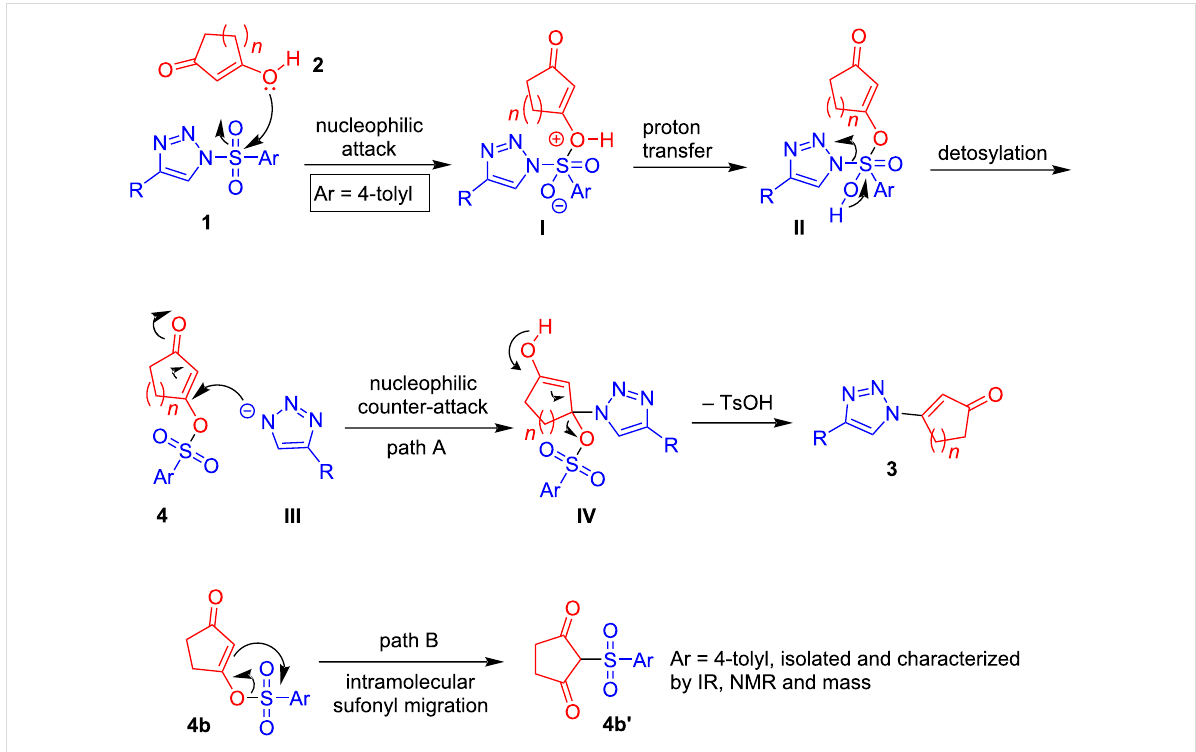
Scheme 4: Mechanistic proposal for the formation of β